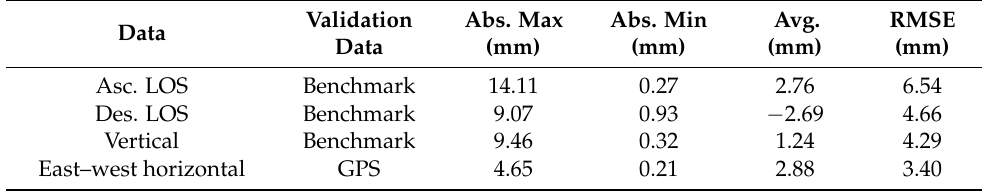
Table 5. Statistics for validating the leveling-constrained multidirectional PS-InSAR 3-D surface displacement estimation